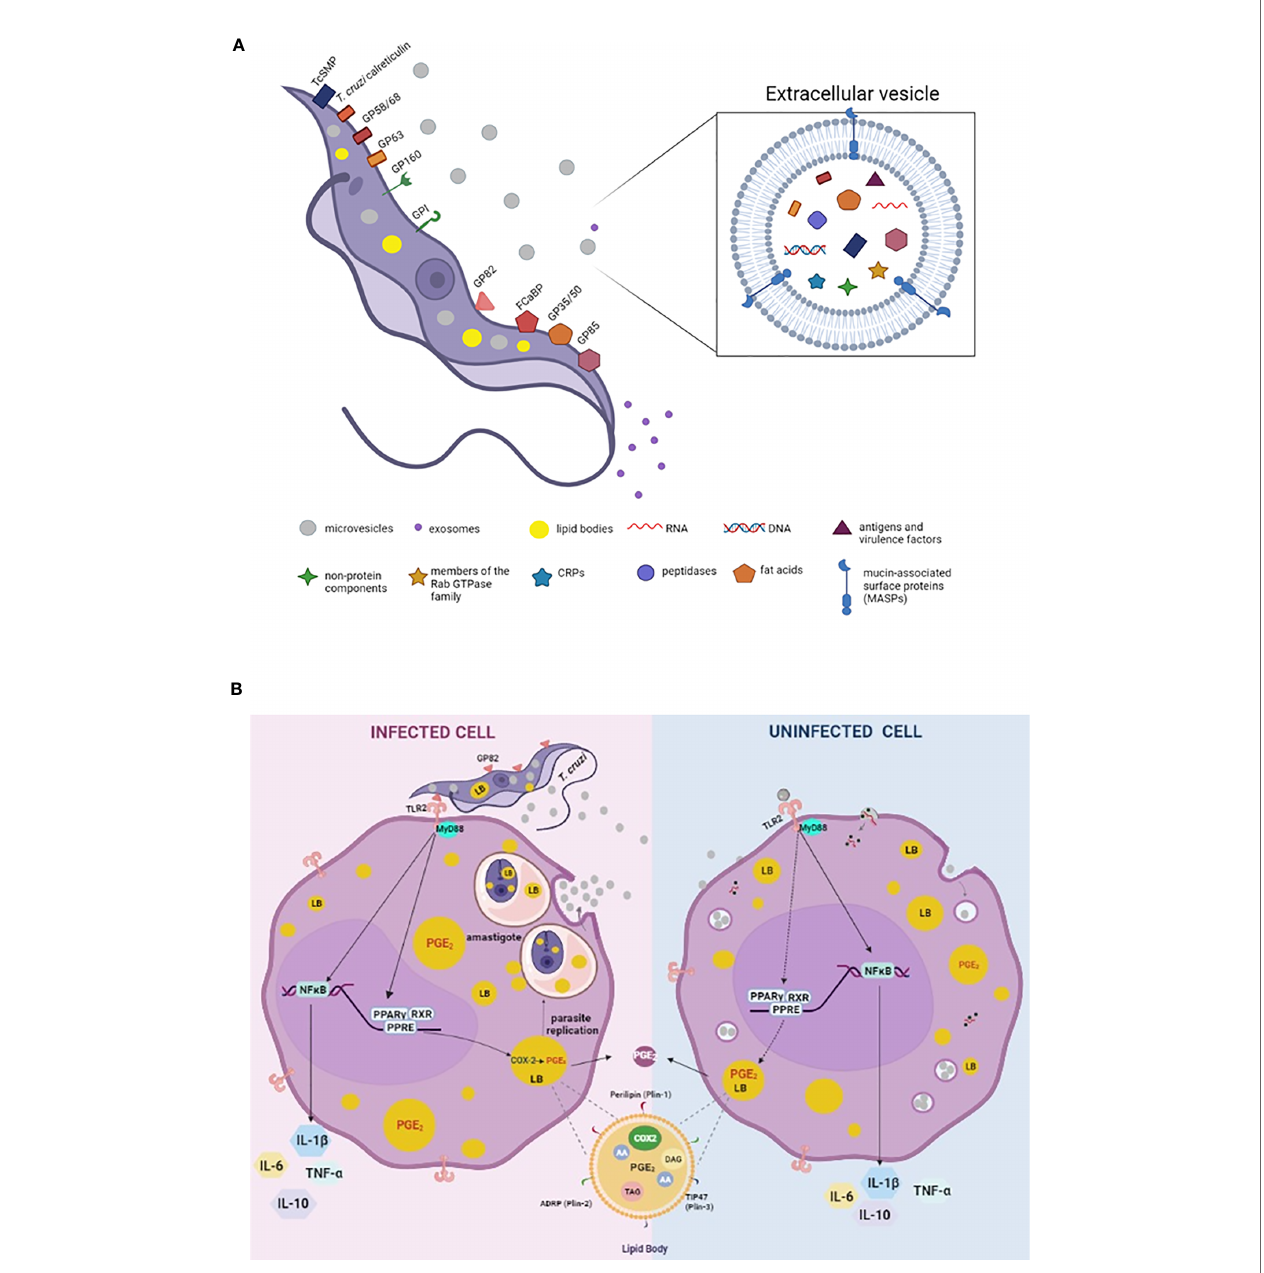
FIGURE 1 | Schematic model summarizing the molecules involved on parasite-host cell interaction process and EVs secreted by trypomastigotes of Trypanosoma cruzi (A) . Mechanisms of action triggered by T. cruzi , EVs and EVsT in macrophages (B) . (A) Parasite exhibiting major components of its membrane associated with EVsT. Note the parasite cytoplasm containing microvesicles, exosomes, and lipid bodies (LBs). In detail, EVsT showing a lipid bilayer containing the main macromolecules carried by these structures, such as DNA, RNA, fatty acids, enzymes, mucin-associated surface proteins (MASP), among others. (B) T. cruzi internalized by macrophage (infected cell) induces LB formation and PGE 2 derived from LBs contributing to amastigote replication, as well as release of microvesicles from the host cell (EVs). We suggest that the EVsT from T. cruzi and EVs from infected host cells are also recognized by uninfected macrophages via TLR2 inducing LB formation and PGE 2 synthesis (dashed lines). However, further studies are needed to de fi ne the receptors and signaling responses induced upon EVs and EVsT- macrophage interaction and how these interactions/responses change as the exosome composition is modi fi ed during an infection. In general, T cruzi and/or EVs/ EVsT via TLR2 active PPAR-y to translocate to nucleus, heterodimerize with RXR and binding to speci fi c DNA response elements (PPRE) in target genes, altering the lipid metabolism and inducing LB formation. The PGE 2 (produced in LB S via COX-2 enzyme activation) is a potent lipid mediator which reduces the host Th1 immune response (by inhibition of the TNF- a and IL-6 and induction of the IL-10) and down modulates the microbicidal function of the macrophage. In parallel, the activation of NK- k B also modulates the synthesis of cytokines. In detail, representation of the structure and composition of LB. Arachidonic acid (AA); cyclooxygenase -2 (COX-2), triacylglycerol (TAG), diacylglycerol (DAG), peroxisome proliferator-activated receptor-y response element